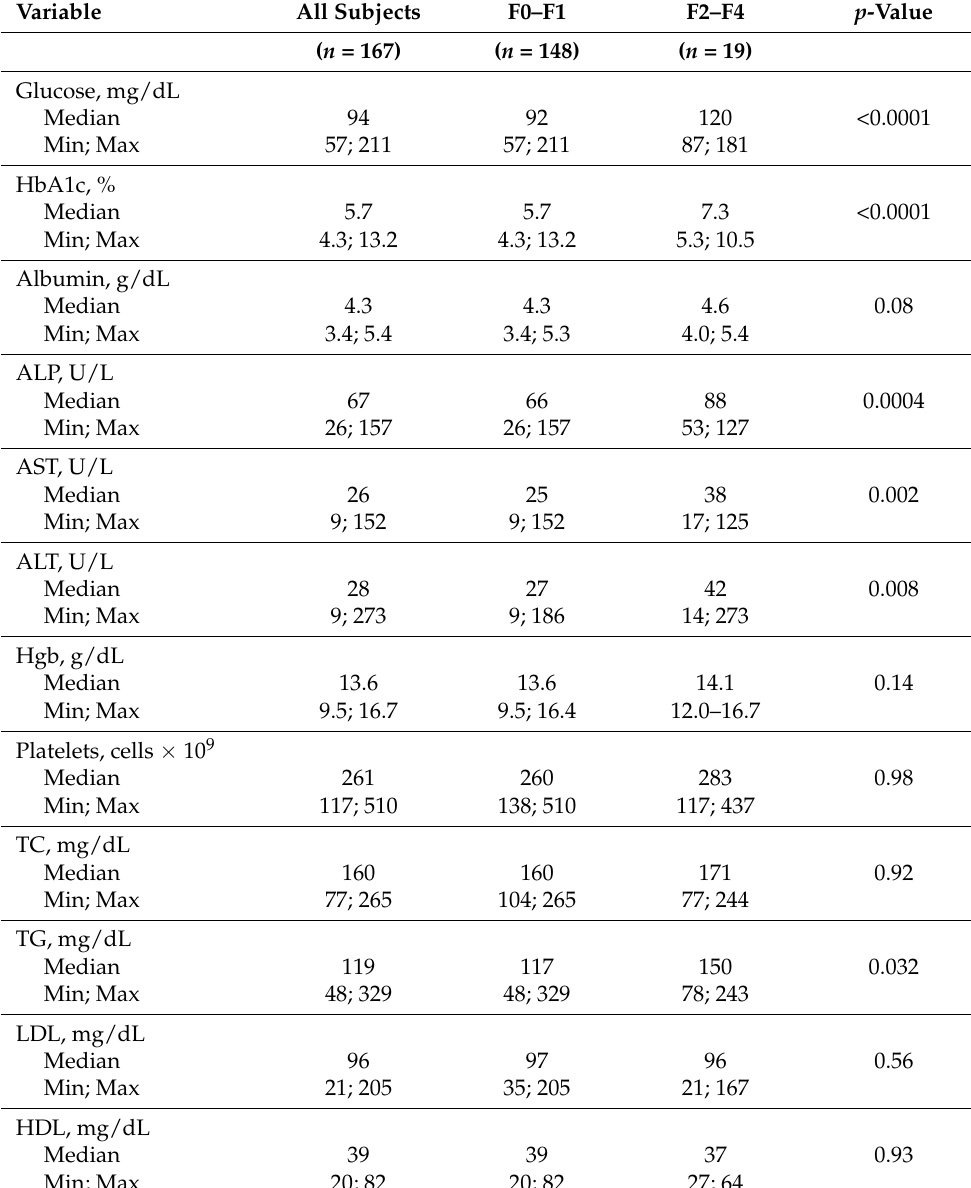
Table 2. Laboratory features of the enrollee subjects who underwent bariatric surgery at our institu- tion between July 2017 and November 2019 ( n = 167).